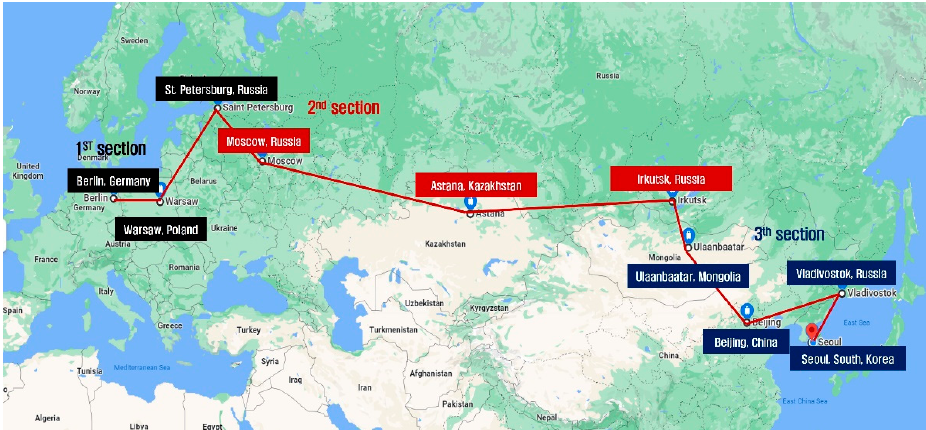
Figure 2. The course of One Korea New-Eurasia Peace Cycle Expedition. 1st section, from Berlin to Moscow (black square), 2nd section, from Moscow to Ulaanbaatar (red square) and 3rd section, From Ulaanbaatar to Seoul (blue